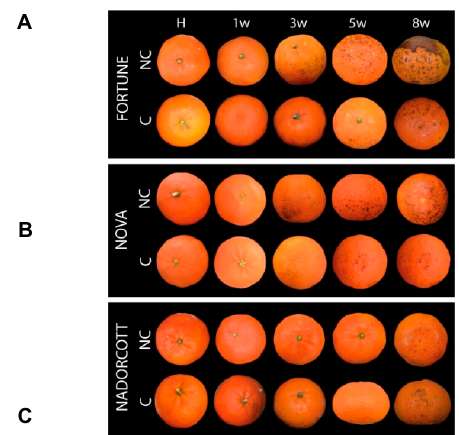
Figure 1. External appearance of fruit of Fortune ( A ), Nova ( B ), and Nadorcott ( C ) at harvest (H) and evolution of chilling injury (CI) symptoms during storage at 2 °C of non-covered (NC) and covered (C) fruit for up to 8 weeks.